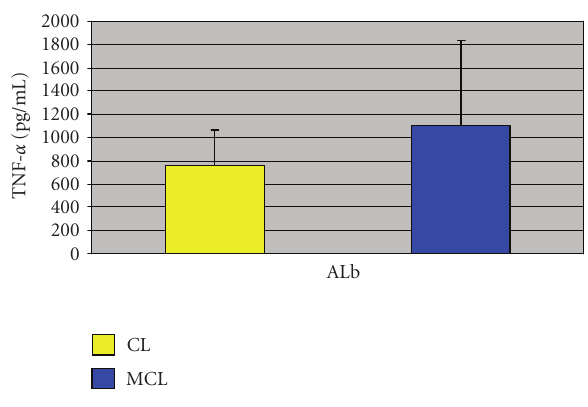
Figure 1: TNF- α production in cell-free supernatants of CL and MCL patients’ PBMCs measured by ELISA upon ALb